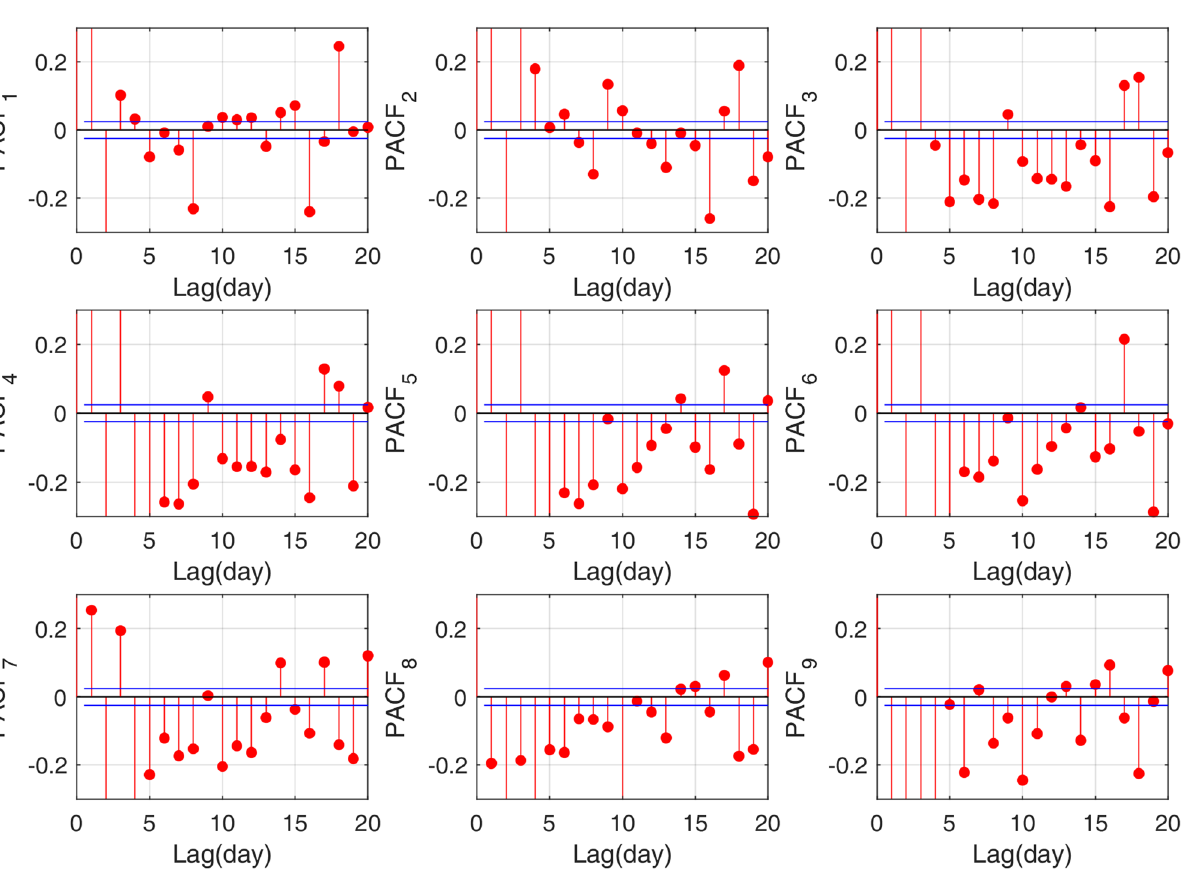
Figure 7. PACFs of subseries of daily streamflow during the period 1997/01/01 to 2014/12/31 for the Yangxian hydrological